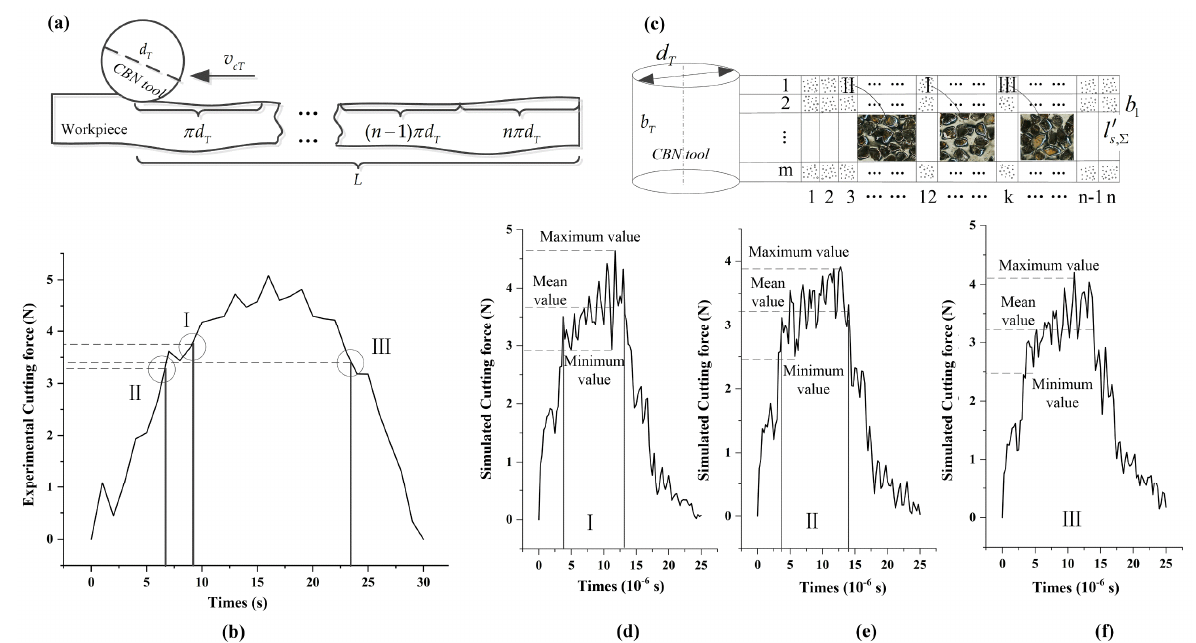
Figure 7. Cutting force between simulation and experiment of multi-milling process. ( a ) Mechanism of equivalent honing processing; ( b ) Honing force for 1 grinding cycle in 30 s; ( c ) Unfold the cylindrical honing wheel into 𝑚 × 𝑛 rectangular cells; ( d – f ) The total honing forces of the engagement areas I, II and III.